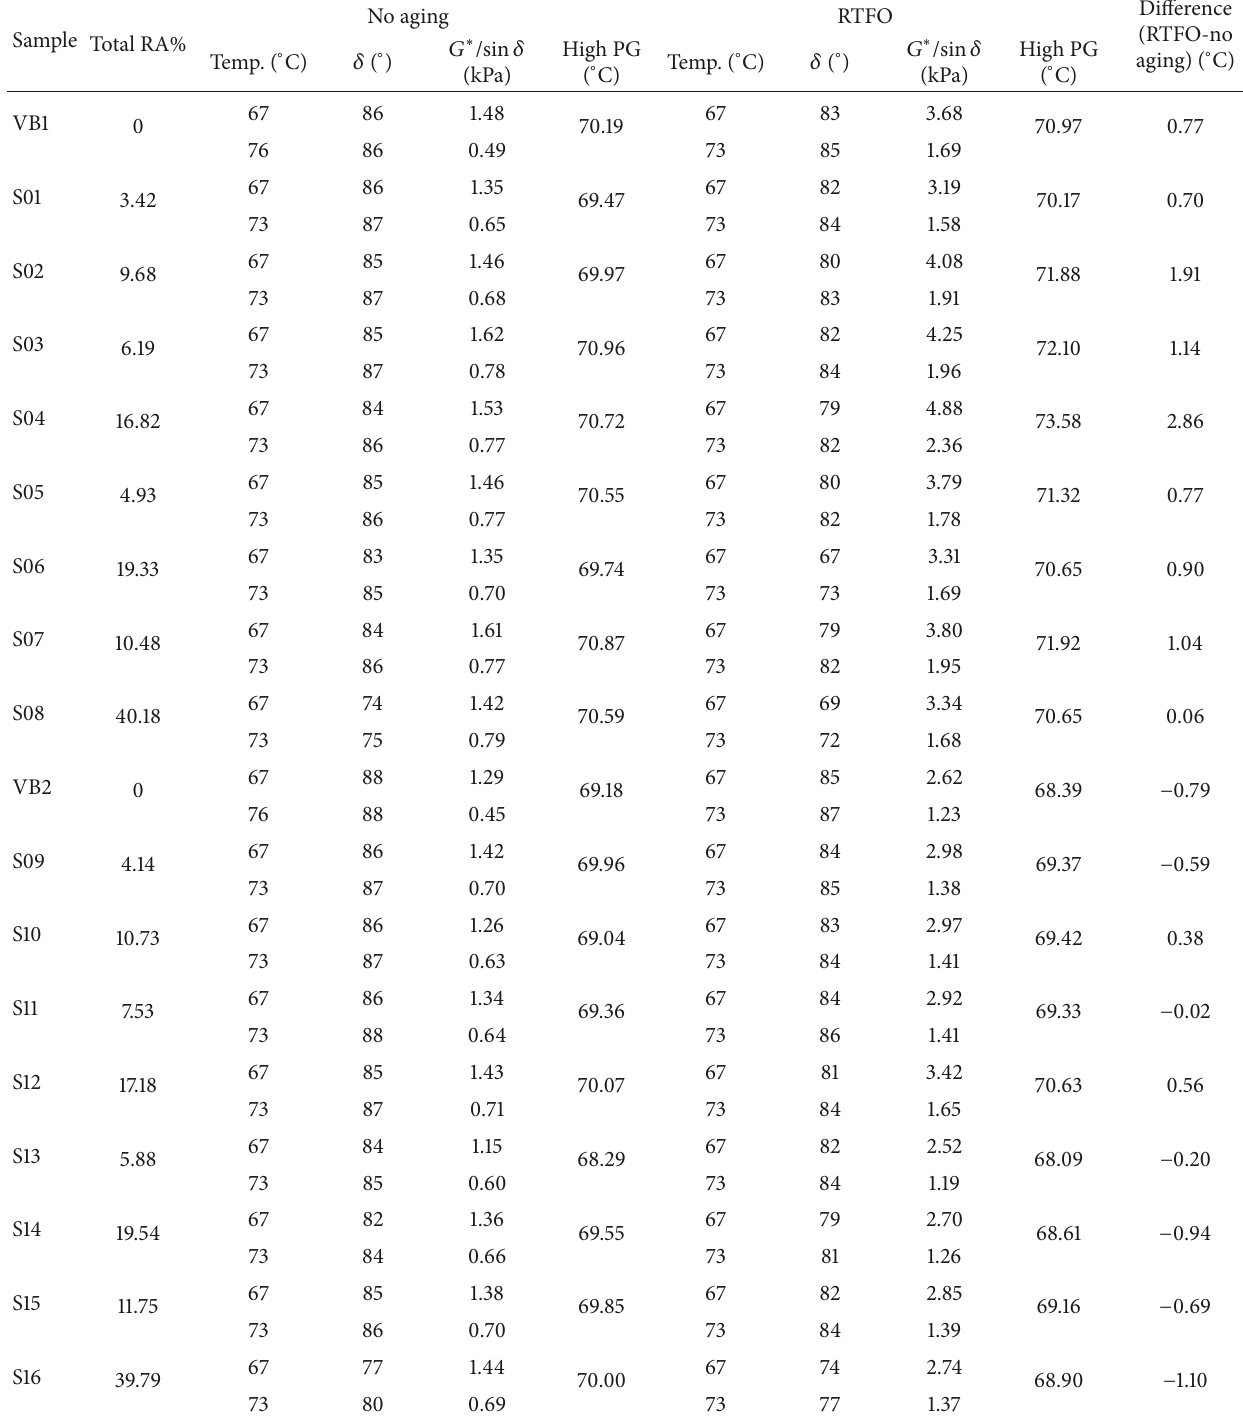
Table 3: High PG of samples based on nonaged and RTFO-aged